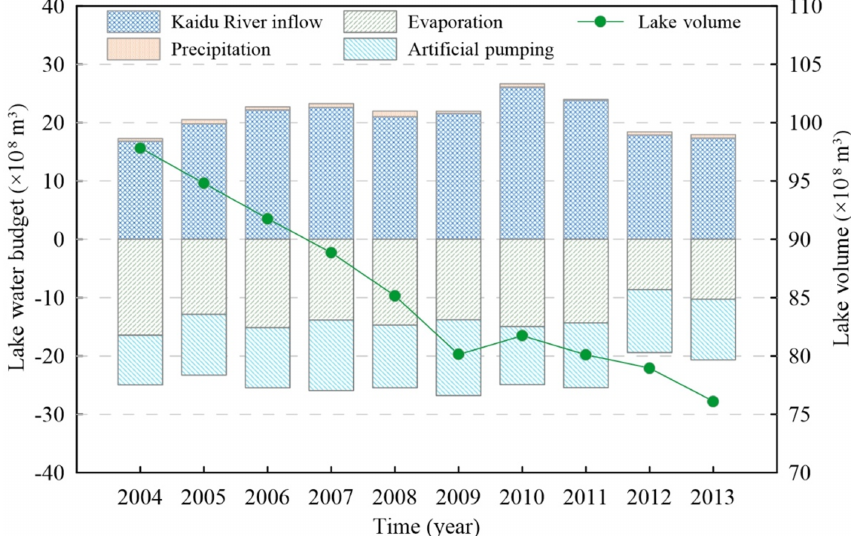
Figure 4. The water balance terms of Bosten Lake and resulting lake volume in the simulation